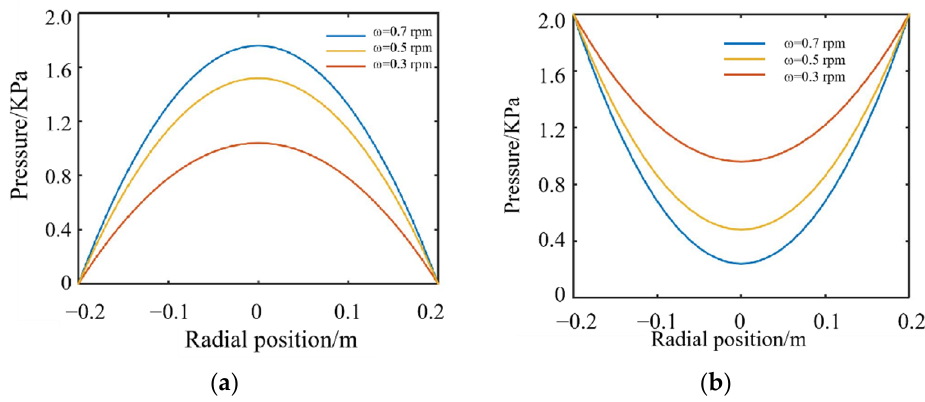
Figure 10. Relationship between liquid film pressure distribution and rotating speed. ( a ) Liquid film